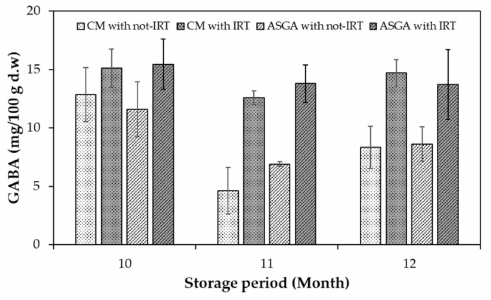
Figure 5. Changes in storage period and GABA content in germinated rough rice (GRR) using the conventional method (CM) and an automatic soaking and germination accelerator unit (ASGA) with and without stimulation via infrared radiation treatment